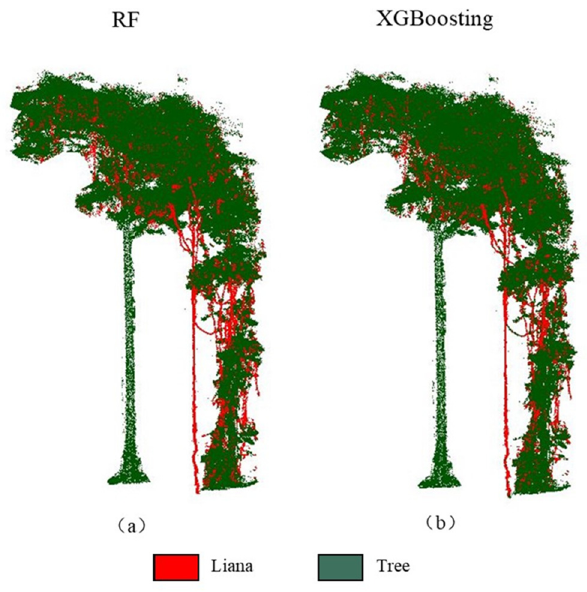
Figure 7. The proposed method based on RF and XGBoosting algorithms after manual intervention. ( a ) RF predictions after manual intervention, ( b ) XGBoosting predictions after manual intervention.